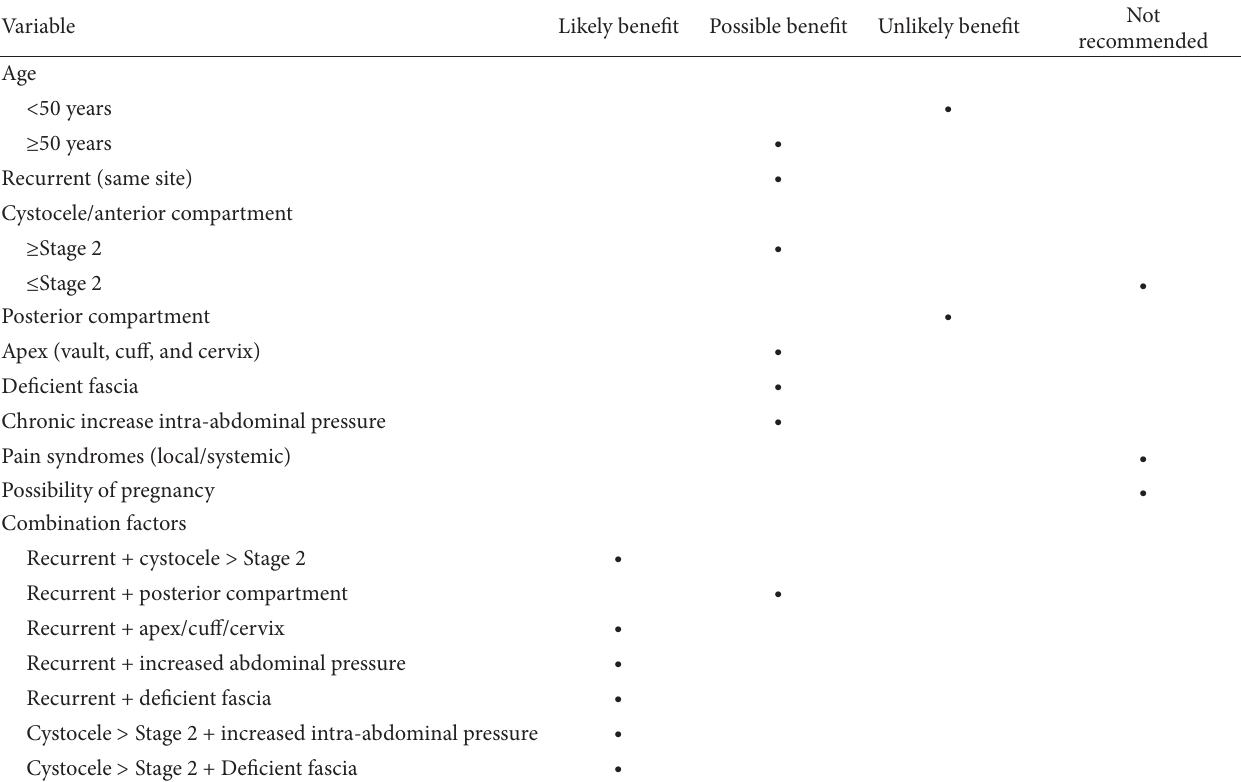
Table 2: Factors to consider for vaginal mesh use in pelvic organ prolapse